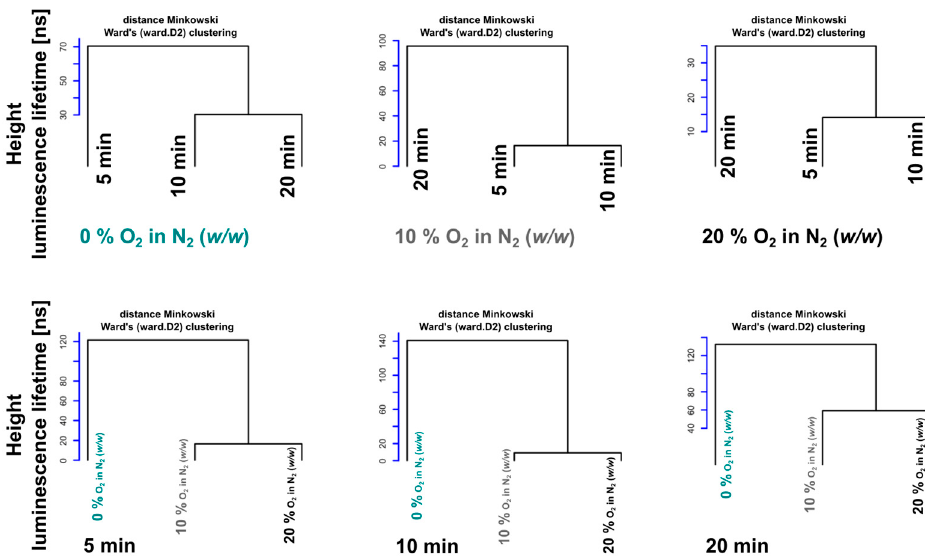
Figure 4. System of sub-dendrograms obtained from [Ru(Phen) 3 ] 2+ luminescence lifetime datasets detected in the blood vessels of the CAM at 5, 10, and 20 min after i.v. administration and 0–20% O 2 in N 2 ( w / w ) atmosphere. The lifetime data set visualization is divided into an upper and a lower part. Each part consists of three dendrograms, which are composed of separately processed data (time-dependent, O 2 in N 2 concentration-dependent). While the first three dendrograms are constructed according to the similarity of the data at given concentrations, the other three are constructed at given detection